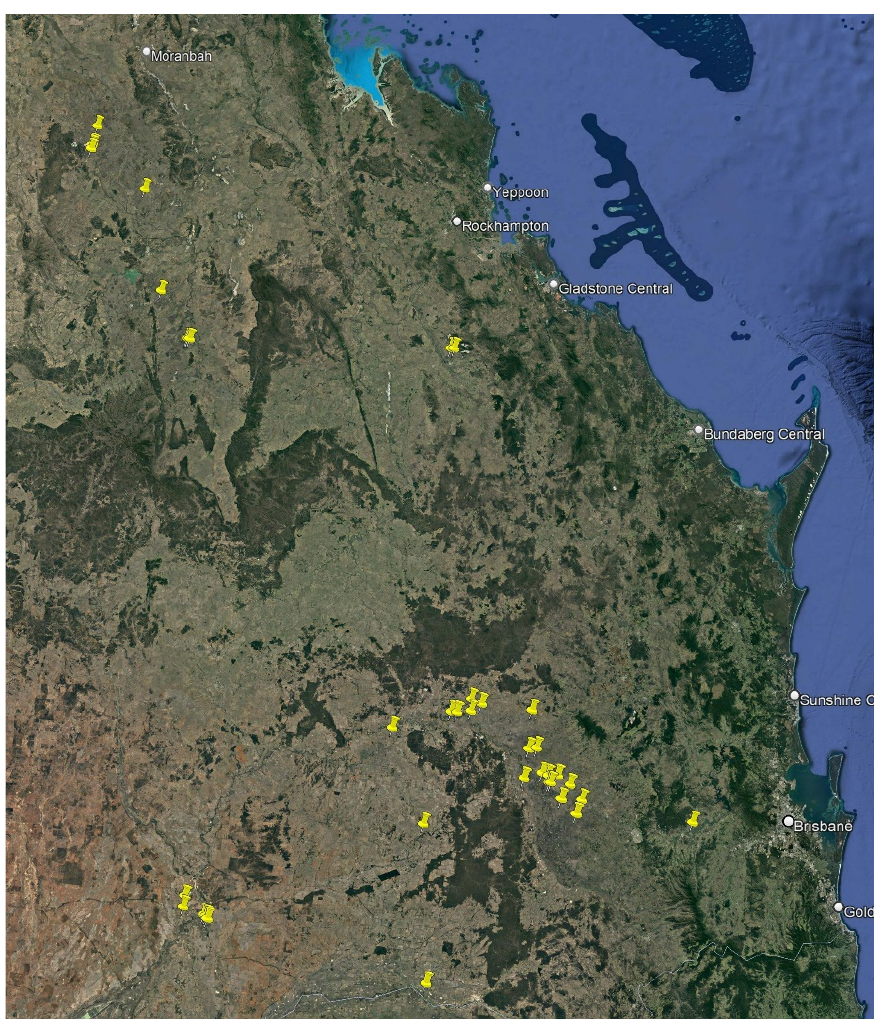
Figure 1. Locations of Chloris virgata populations collected from Queensland, Australia.